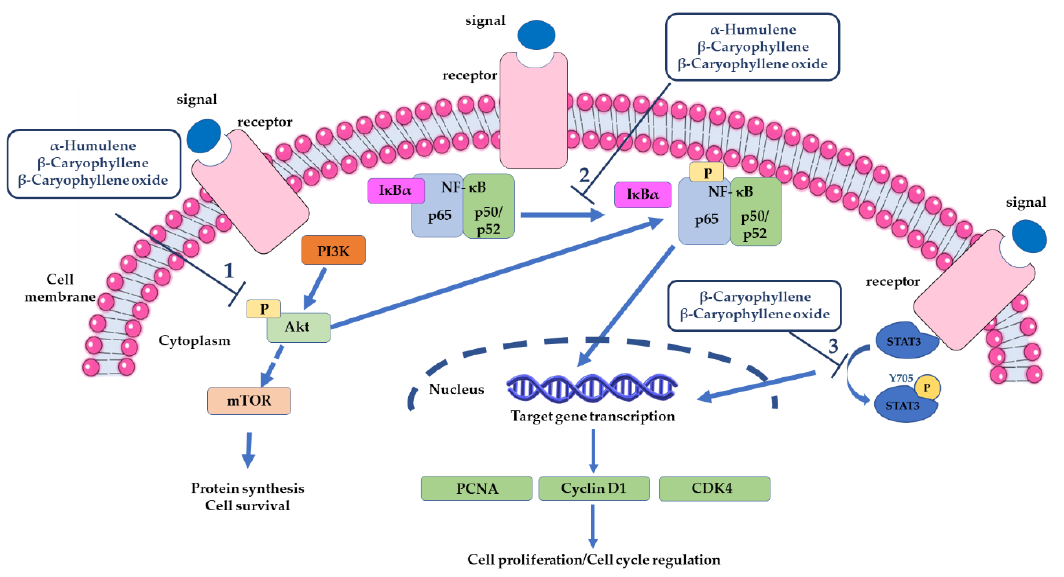
Figure 7. Major intracellular signalings involved in the antiproliferative and pro-apoptotic effects of β-caryophyllene, β-caryophyllene oxide, and α-humulene in cancer cells. A modulation in Akt (cellular homolog of murine thymoma virus Akt8 oncogene) signaling has been found associated with apoptosis induced by α-humulene in liver cancer cells [210]. Indeed, a lowering in Akt phosphorylation along with increased p21 and decreased cyclin D1 levels, likely due phosphatidylinositol 3-kinase (PI3K)/Akt/mammalian target of rapamycin (mTOR) axis